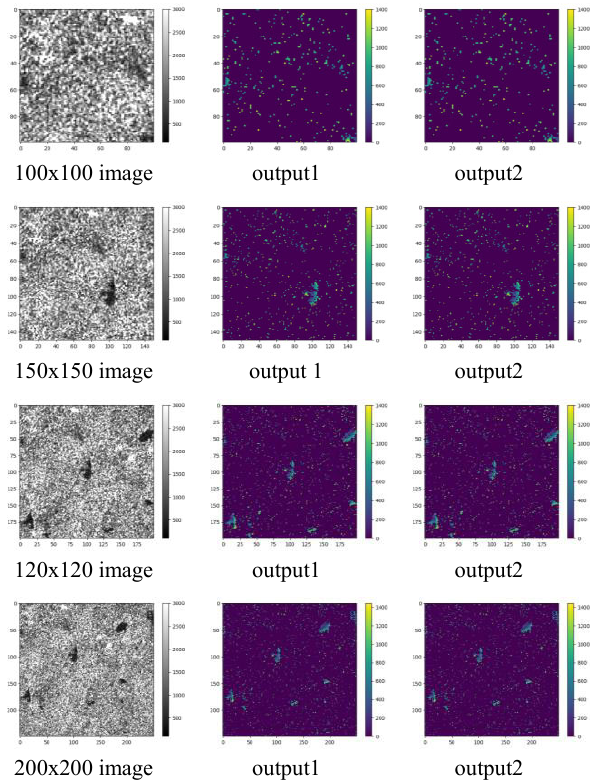
Figure 5: Output of GLCM computations, output1 is from normal matrix based operation and output2 is from the proposed tool